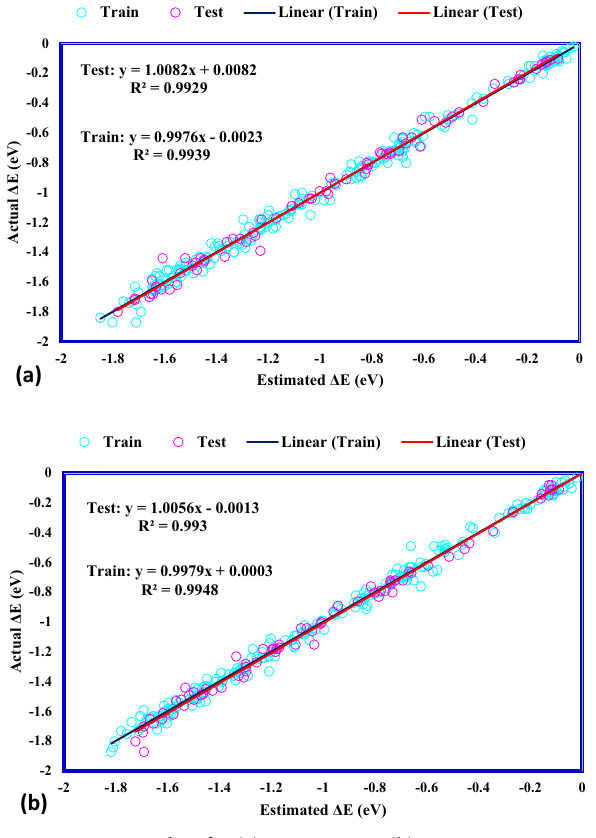
Figure 7. Cross plots for ( a ) ANFIS–PSO, ( b ) ANFIS–GA.